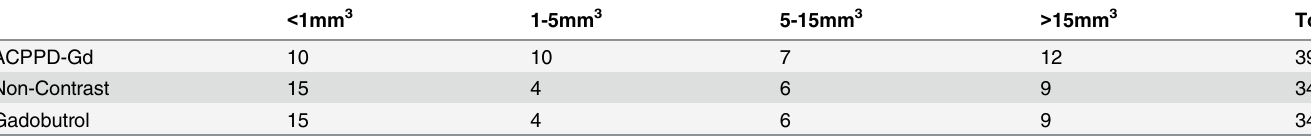
Table 1. Distribution of Tumor Size for each Contrast Group.